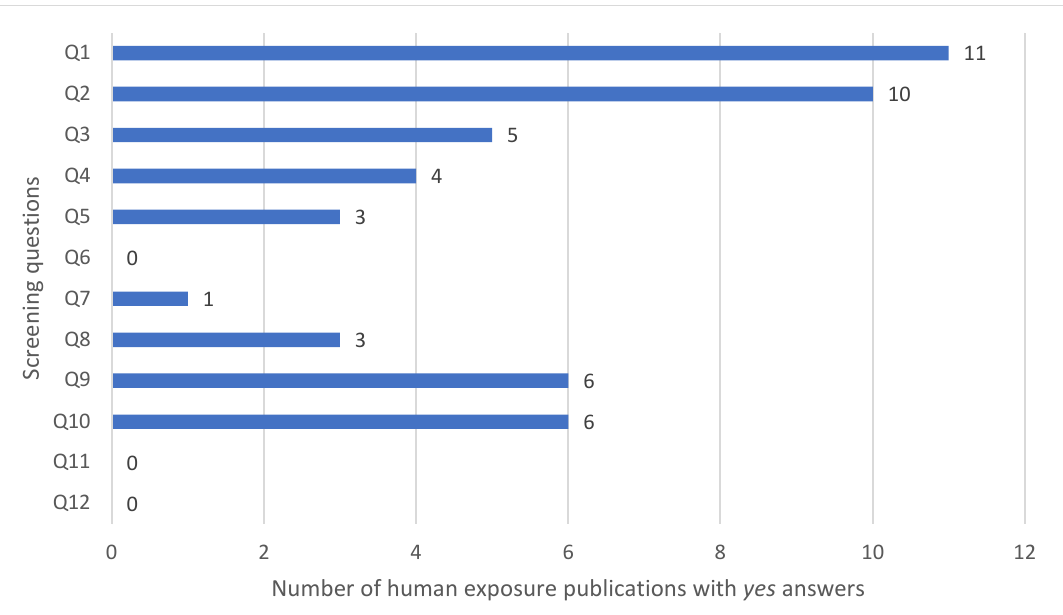
Figure 6 . Displays the number of publications in the human exposure category that correspond with “yes” per each screening questions (n = 11).